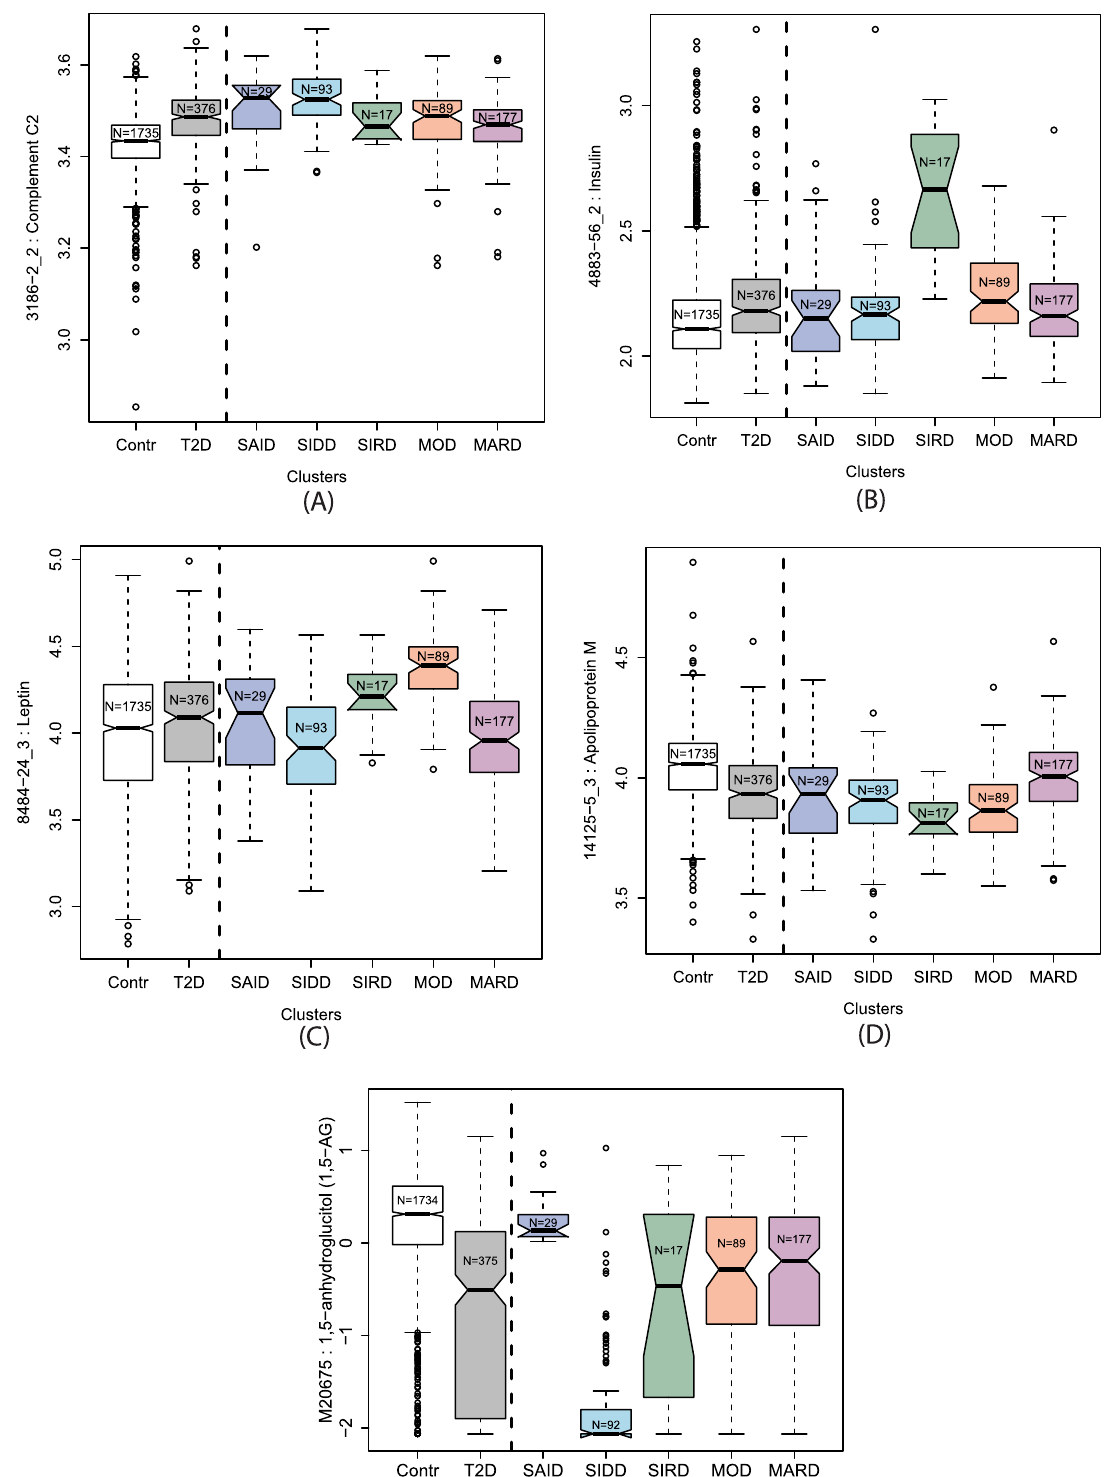
Fig. 6 | Boxplots of the signi fi cantly altered proteins or metabolites in speci fi c diabetes subtypes. A Complement C2 (C2), B insulin (INS), C leptin (LEP), and D Apolipoprotein M (APOM) are signi fi cantly higher in SIDD, SIRD, MOD, and MARD, respectively, while E 1,5-AG is signi fi cantly lower in SIDD. The complete set of boxplots for all protein and metabolite levels for each cluster are in Supple- mentary Data 1 and Supplementary Data 2. Contr Controls, T2D type 2 diabetes,